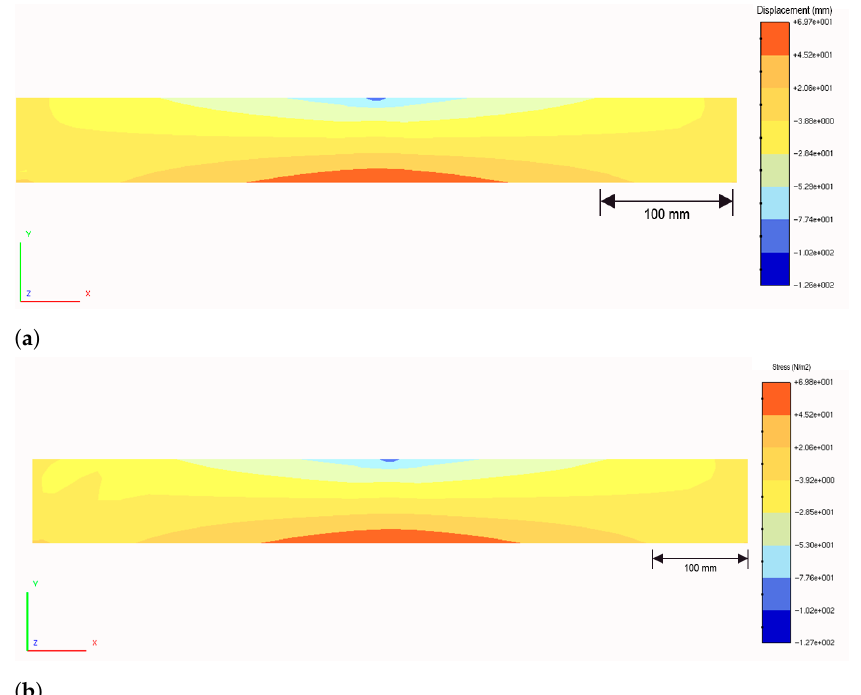
Figure 16. Normal stresses, σ xx (in MPa), in the internal plane ( a ) BE analysis I: image displacement- measured displacement exclusively applied at the supports ( b ) BE analysis II: image displacement- measured data applied at the hatched area and supports.